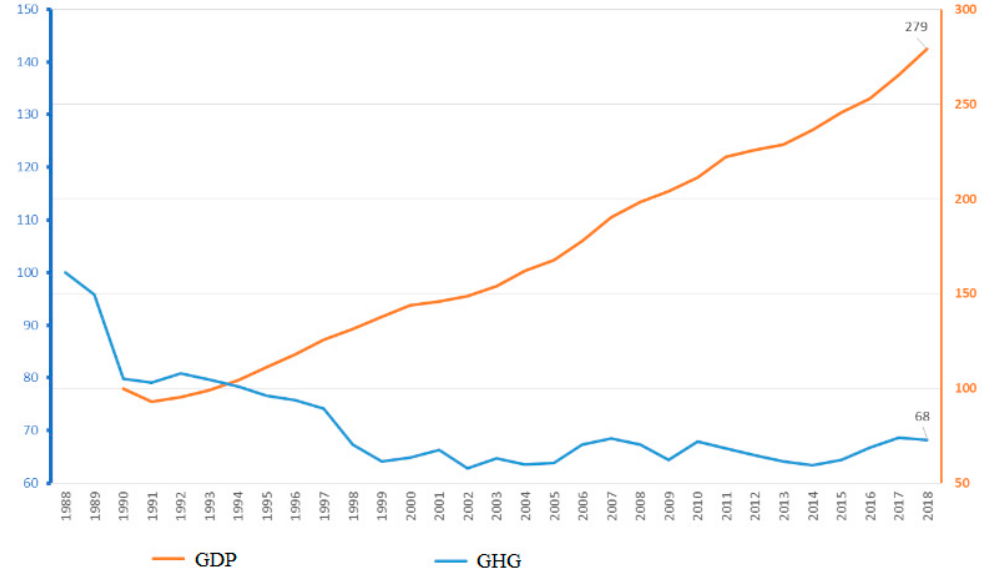
Figure 36. Relation of GDP dynamics to greenhouse gas emissions (1988–2018) [81].